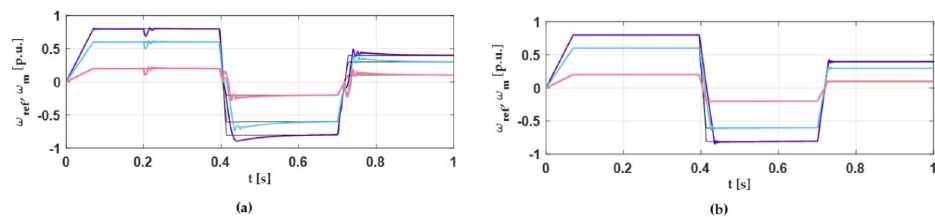
Figure 3. Speed transients for a few different reference values in scalar control ( a ) and field-oriented control ( b ).